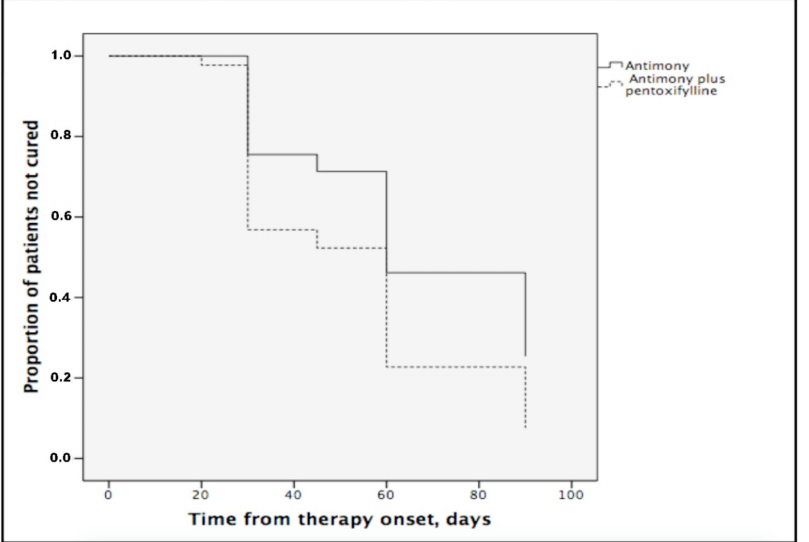
Figure 1. Kaplan-Meier estimates of the proportion of patients not cured with antimony or antimony plus pentoxifylline (Log-rank tzest; p =